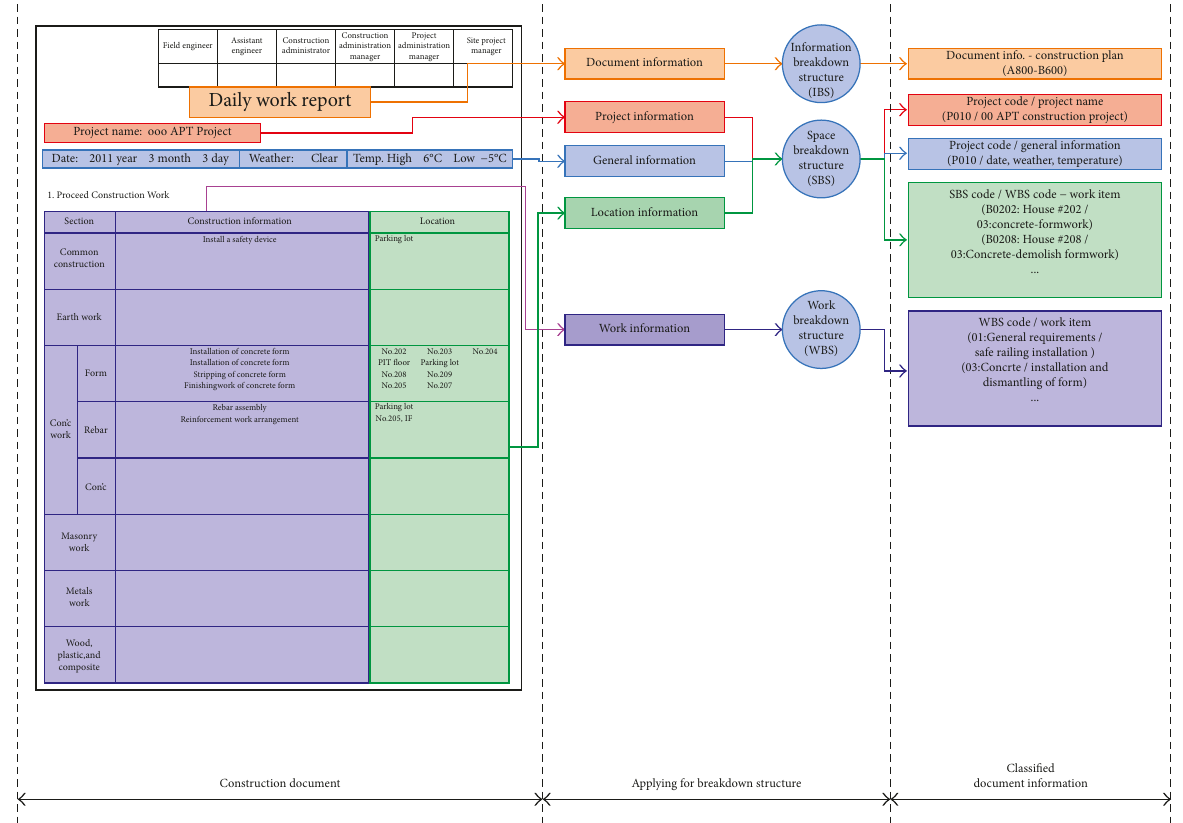
Figure 3: Application of categorization systems (example: daily work